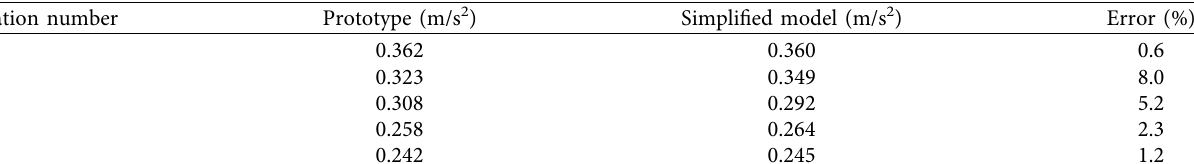
Table 16: The vertex peak acceleration of prototype and the simplified model.